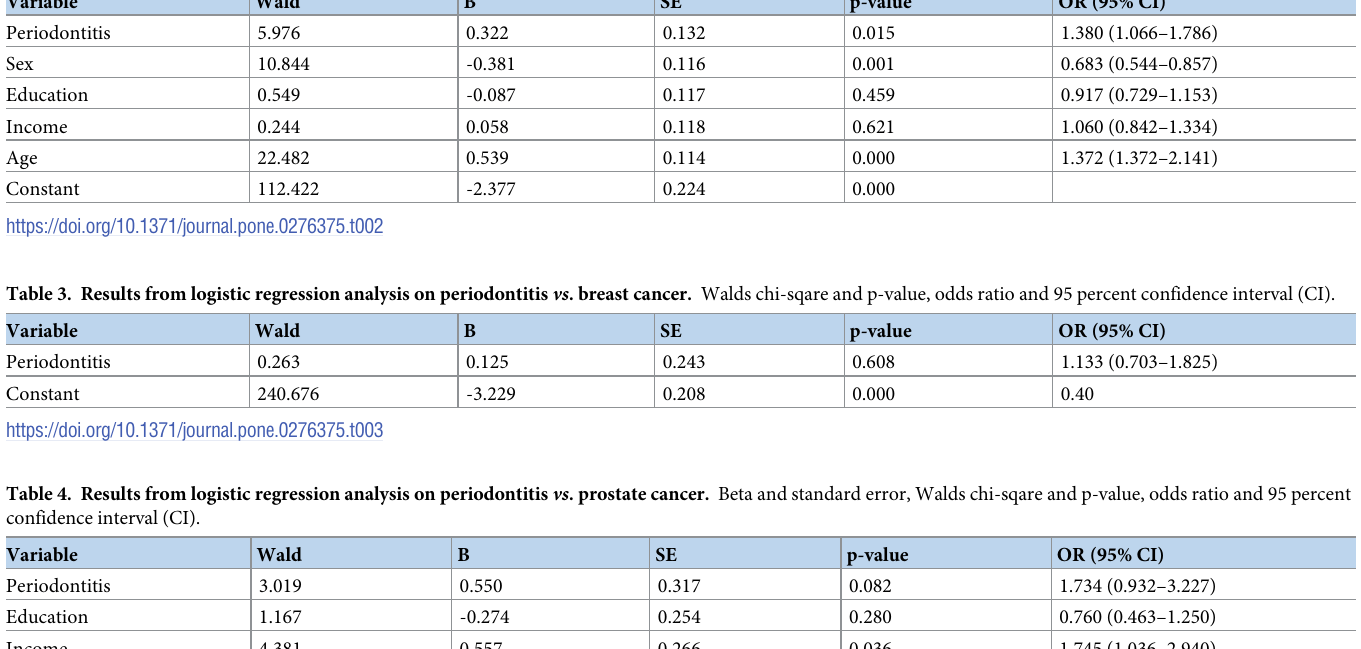
Table 2. Results from logistic regression analysis on periodontitis vs . any cancer. Beta coefficient and standard error, Walds chi sqare and p-value, odds ratio and 95 percent confidence interval (CI). Variable Wald B SE Periodontitis